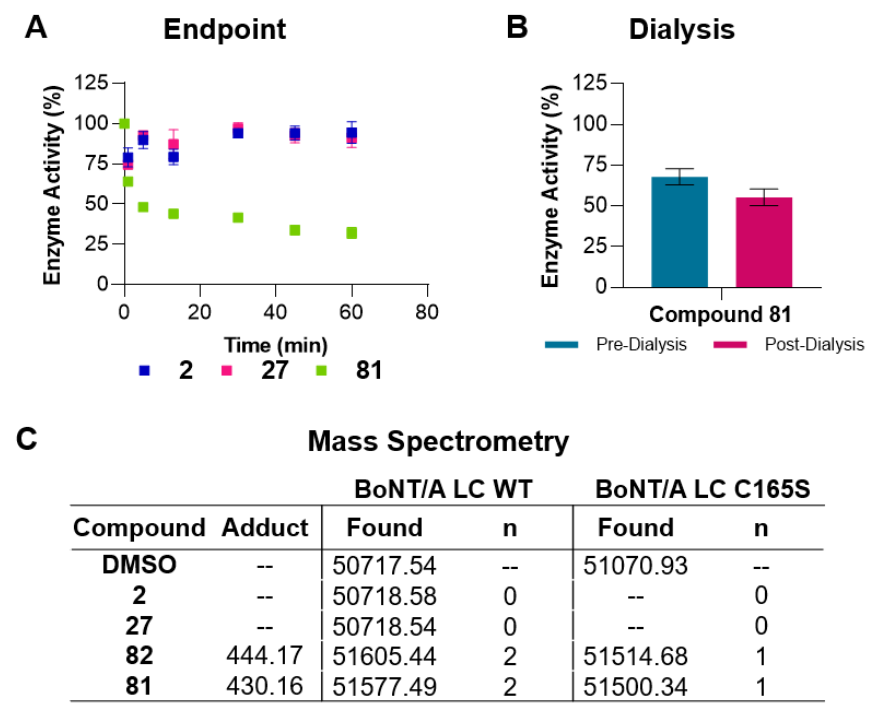
Figure 4. ( A ) Endpoint assay for compounds 2 , 27 , and 81 incubated at 5 µM against BoNT/A LC (10 nM). Data points normalized to a DMSO control and represent the mean activity ± SD, n = 3. ( B ) Effect of dialysis on enzyme activity of BoNT/A LC (500 nM) incubated with compound 81 (5 µM). Data points normalized to a DMSO control and represent the mean ± SD, n = 3. ( C ) Covalent adduct formation by compounds 2 , 27 , 81 , and 82 (100 µM) incubated with BoNT/A LC WT or C165S variants (40 µM) at 37 °C for 30 min.